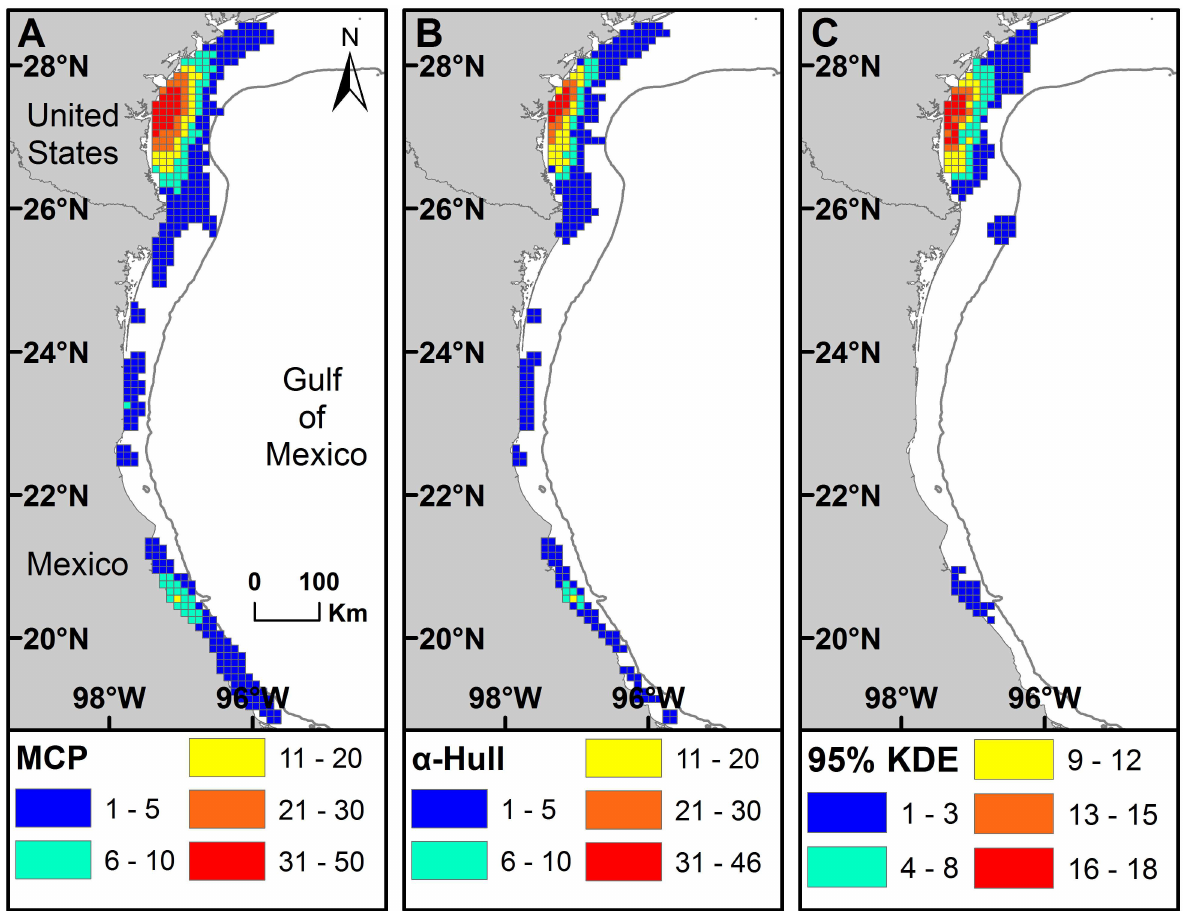
Fig 5. The number of individual Kemp’s ridley turtles with (A) Minimum Convex Polygons (MCPs), (B) α -Hull, and (C) Kernel Density Estimates(KDEs: 95%) for home range in each 10 km grid cell. Each inter-nestingperiodwas countedonce throughoutall grid cells in each of the A, B, and C